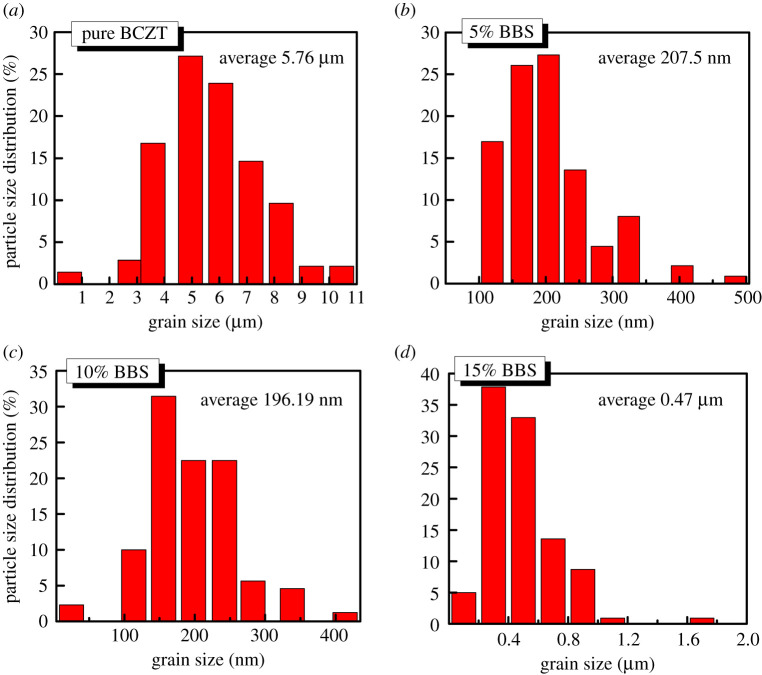
The grain size distribution of (1 − x)BCZT-xBBS glass ceramics. (a) x = 0, (b) x = 0.05, (c) x = 0.1, (d) x = 0.15.